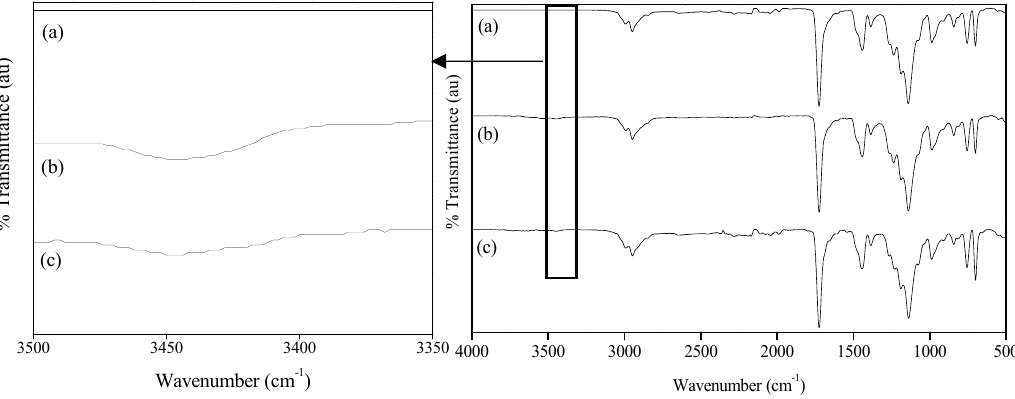
Figure 5. FT-IR spectra of the different synthesized particles ( right ), St-MMA ( a ), St-MMA-PEGMA particles ( b ) and St-MMA-GMA-PEGMA particles ( c ) and ampliation of FT-IR spectra of the different synthesized particles ( left ), St-MMA ( a ), St-MMA-PEGMA particles ( b ) and St-MMA-GMA-PEGMA particles ( c ), for wavenumber between 3350 and 3500 cm − 1 .